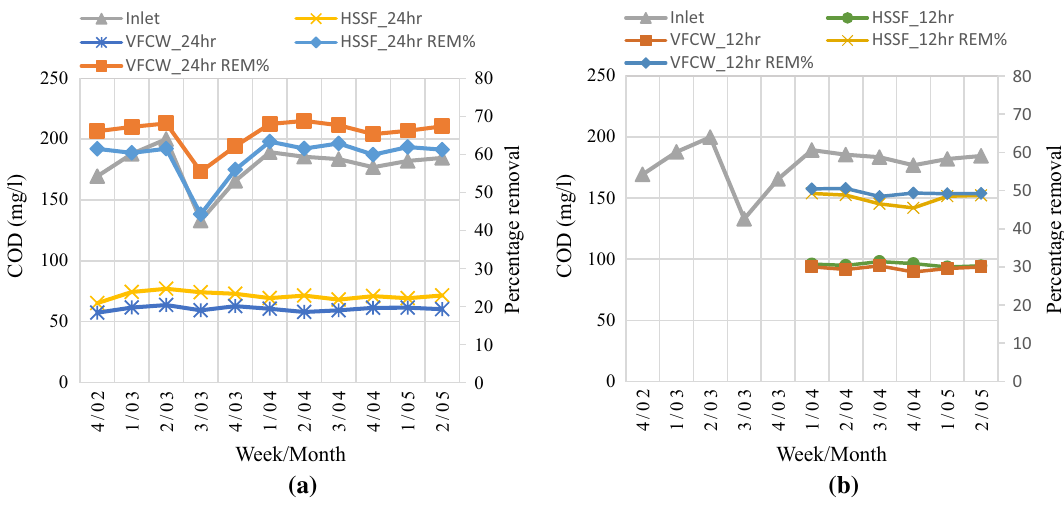
Fig. 5 a COD influent, effluent concentration and percentage removal of HSSF-CW and VFCW for 24-h HRT, b COD influent, effluent concen- tration and percentage removal of HSSF-CW and VFCW for 12-h